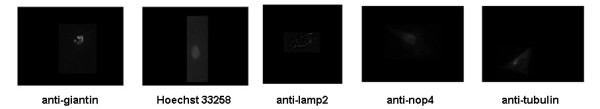
Sample CHO images.